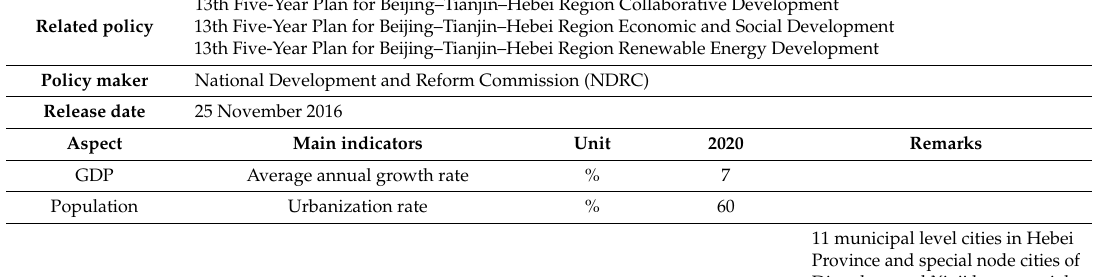
Table 6. Energy transition targets related to regional integrated development in Beijing–Tianjin–Hebei region. Related